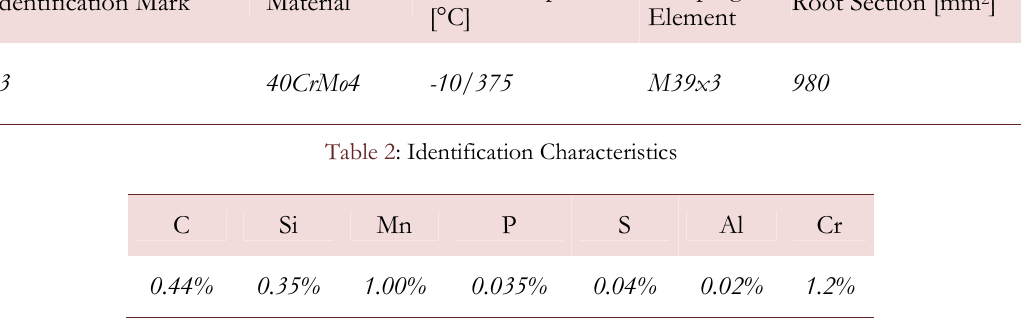
Table 3: 40CrMo4 heat-treated steal chemical